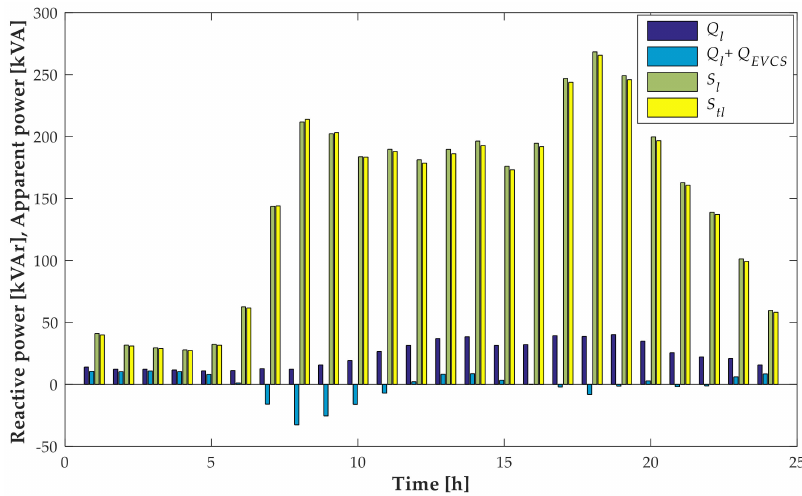
Figure 10. Reactive and apparent power loading of T 1 with ( S tl ) and without reactive power ( Q EVCS ) from EVCSs ( S l ), with 4% increase in EVCS demand.